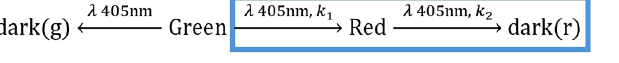
Figure 8. Kinetic model of SAASoti